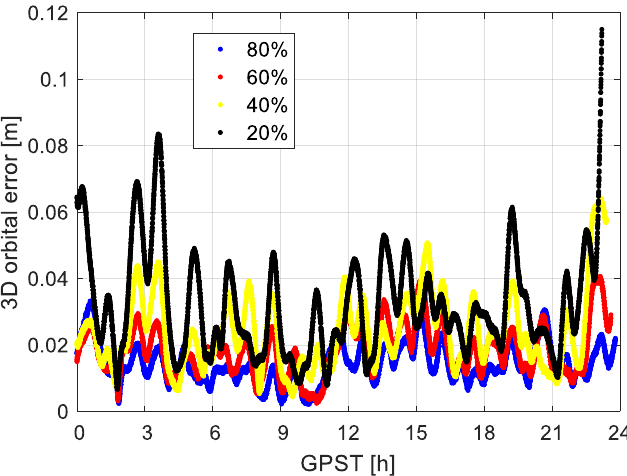
Figure 4. 3D orbital errors for different duty-cycles (from 20% to 80%) of the phase-based reduced- dynamic orbits using data of GRACE FO-1 with a sampling interval of 10 s. The elevation mask was set to 5 degrees with a mean satellite number of about 9.